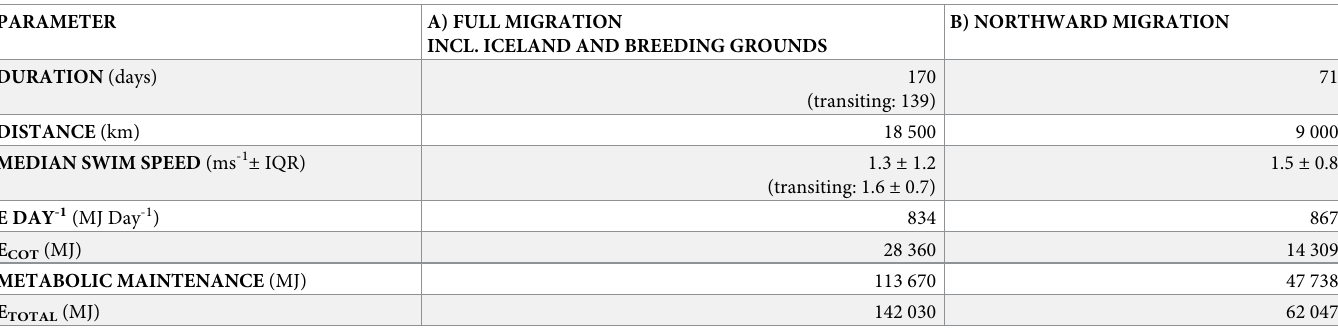
Table 2. Energetic cost of